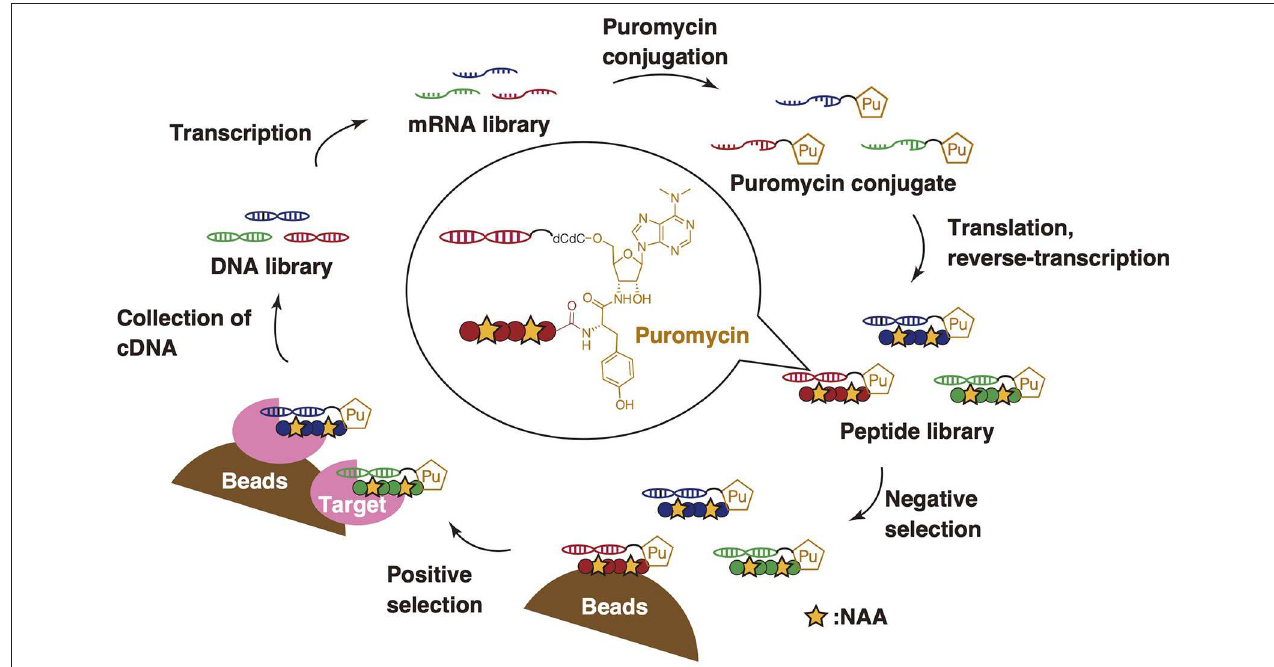
FIGURE 11 | General scheme of the RaPID system. An mRNA library is transcribed from a DNA library and is then conjugated to puromycin. The peptides containing NAAs are subsequently translated based on mRNAs by employing genetic code reprogramming. At the end of translation, each puromycin combined with the mRNAs is connected to the C-terminus of corresponding peptides via an amide bond to produce a peptide-puromycin-mRNA library. Peptide ligands are obtained by affinity-based screening from its library through positive and negative selection. cDNAs from binding peptides are subsequently collected and amplified by PCR, and, finally, the cycle of the RaPID system is